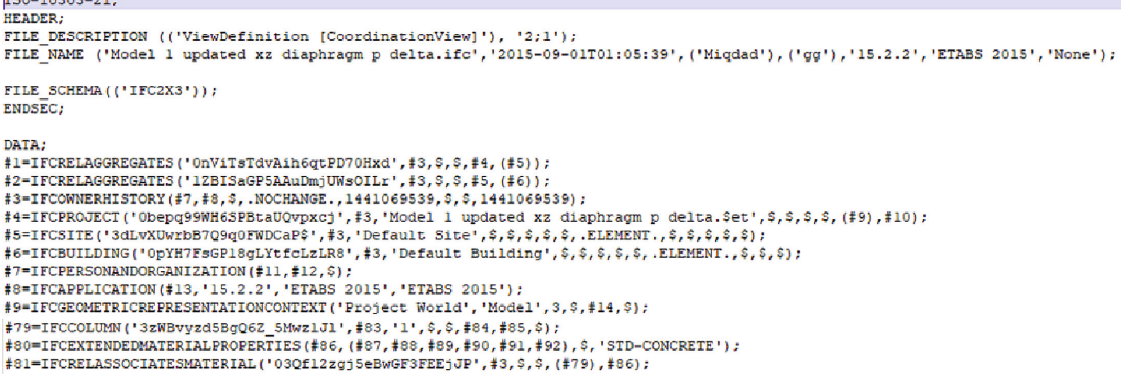
Figure 4: Sample IFC entities representation.